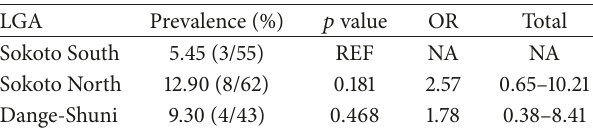
Table 4: Univariable analysis of Escherichia coli isolates from raw milk in three Local Government Areas